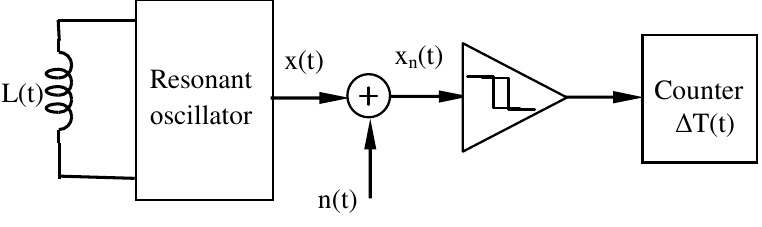
Figure 3. Block scheme of a resonant